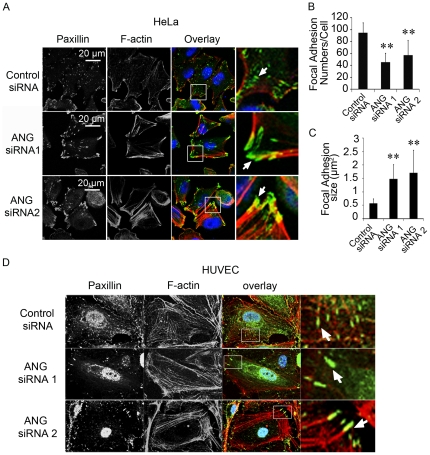
Down-regulation of ANG increased the formation of focal adhesions.(A) HeLa cells were treated with control siRNA, ANG siRNA 1 or ANG siRNA 2 for 48 h, then fixed and stained with rhodamine-phalloidin (red) and anti-paxillin antibody (green). Nuclei stained with DAPI (blue). (B) Numbers of paxillin-staining focal adhesions was quantified for control and ANG knockdown cells using ImageJ software. Seven cells were analyzed per condition in each experiment. Three independent experiments were performed. **P<0.01. (C) Average size of paxillin-containing focal adhesions in control and ANG-deficient cells. **P<0.01. (D) HUVECs were treated with control siRNA or ANG siRNAs, fixed, and stained with rhodamine-phalloidin (red) and anti-paxillin antibody (green). Nuclei were stained with DAPI (blue).